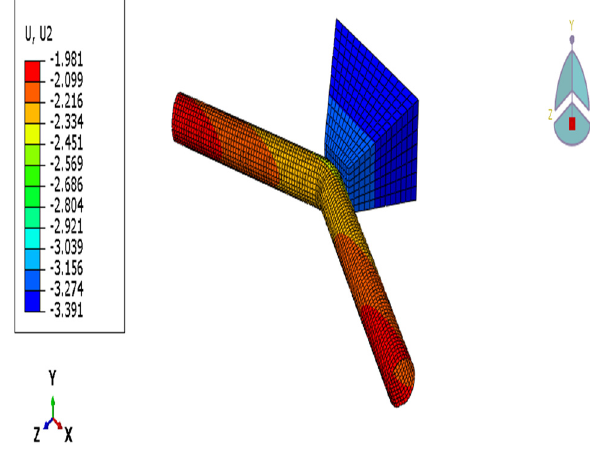
Figure 17: Vertical displacement of thrust block ( mm )